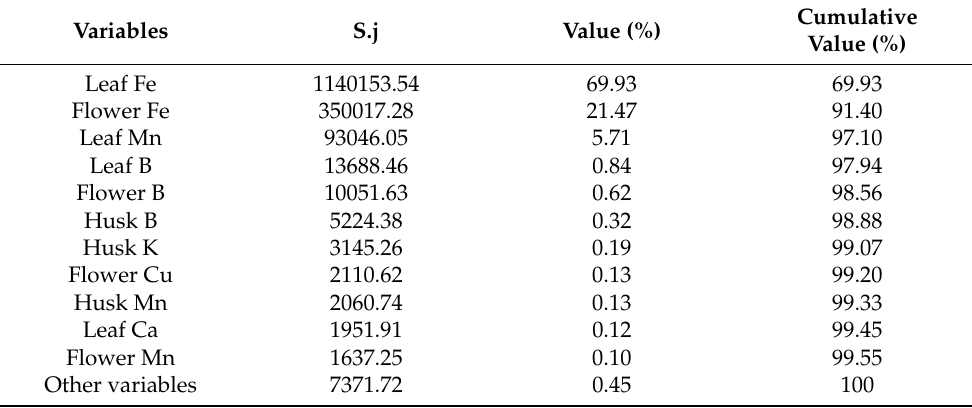
Table 3. Clustering of 16 Coffea canephora genotypes by the Tocher method based on the Euclidean distance, considering the nutrient concentrations of flowers, grains, husks, and leaves. Alta Floresta D’Oeste, Rond ô nia, Brazil. Groups (Tocher) Genotypes Groups (UPGMA) I AS4, GJ03, AS2, A106 V II AS1, AS7, VP06, GJ25 * AS10; LB080, SN41, L140 GJ08 ZD156 * AS6 LB015